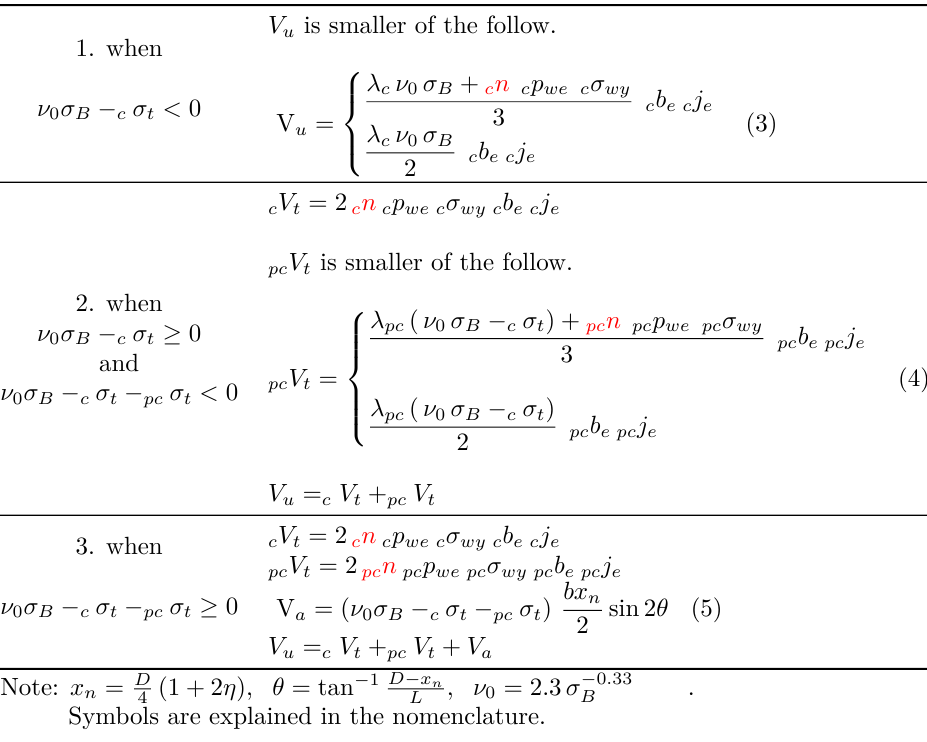
Table 4. Pile cap shear strength formula based on previous